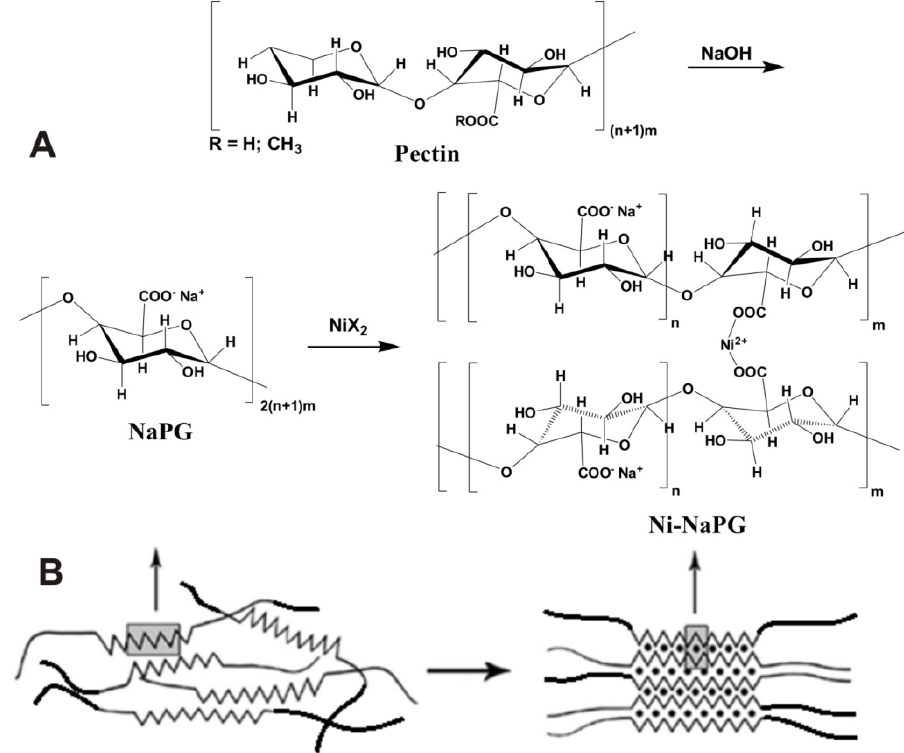
Figure 1. Schemes for the synthesis of pectin polysaccharide complexes ( n = 3–10; m = 10–35) with nickel ( A ) and the formation of polymer-complex structures according to the “egg-box” [28] model ( B —right).